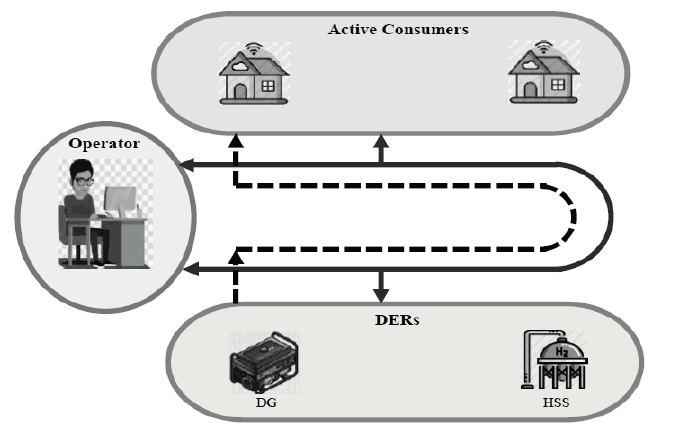
Fig. 1. Background of the smart autonomous electrical